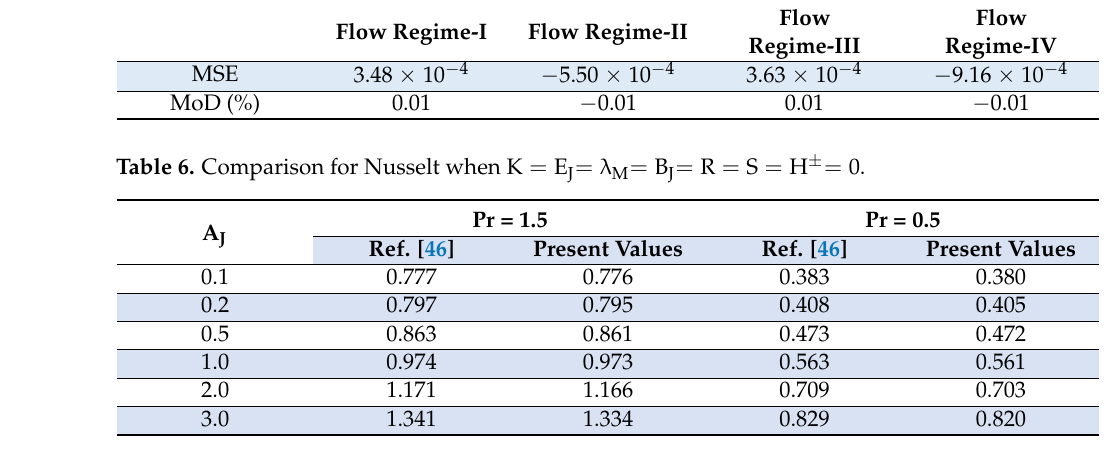
Table 5. Performance parameter results for each flow regime.